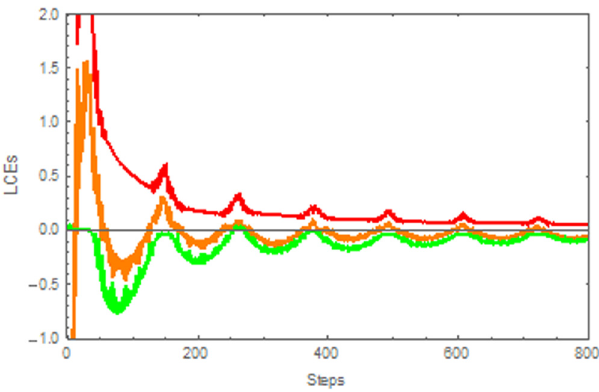
Figure 2: The convergence plot of the LEs for Hide ’ s model where initial conditions and parameter values = { } x 0, 4.9, 5.641 0 , = β 1 , = α 50 , = λ 0 , = κ 0.1 .